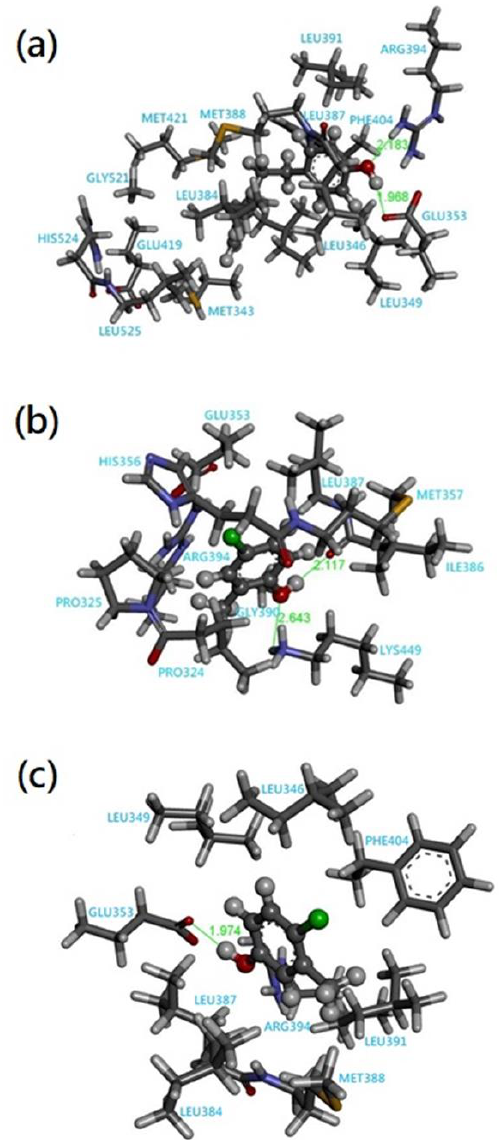
Figure 3. The quantum chemical cluster models for the ERα receptor (PDB 3ERT) with phenols: (a) 4-Chloro-3-methylphenol, (b) 4-Phenethylphenol, and (c) 4-Chloro-2-methylphenol. The values of binding affinity for DDT ranged from − 21.21 kcal/mol to − 26.62 kcal/mol. The results show that DDT tends to bind to the ERα receptor and achieves en- docrine disrupting functions through hydrogen bonds or salt bridge interactions at either end of the steroid binding site [40]. The hydroxyl group of 2,4-Dihydroxybenzophenone ( − 24.37 kcal/mol) forms a hydrogen bond with the side chain of Leu387 (Figure 4a). Be-